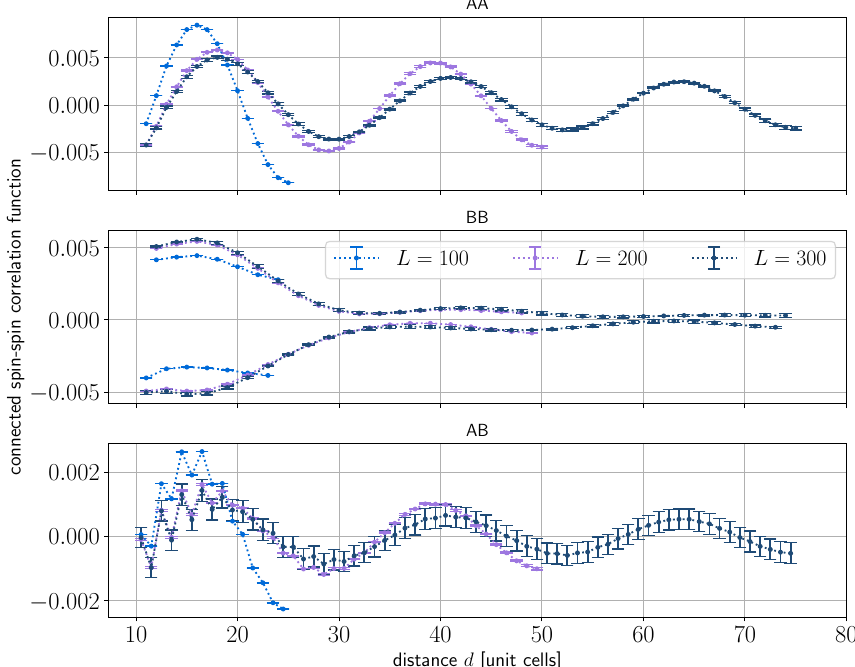
Figure 13: Connected spin-spin correlations (Eq. (A.15)) as a function of the distance measured in unit cells, averaged over all possible initial sites for the apical-apical (AA), basal-basal (BB) and apical-basal (AB) correlations. The standard deviation of the resulting distribution is taken as the